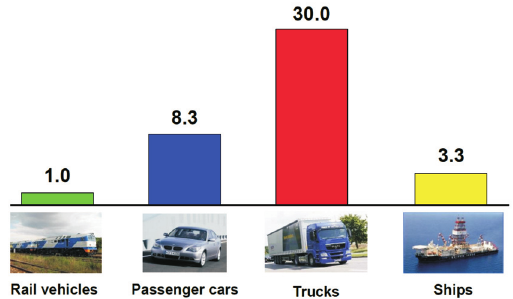
Fig. 5. Relative environment burden by the above means of transporta - tion [22]